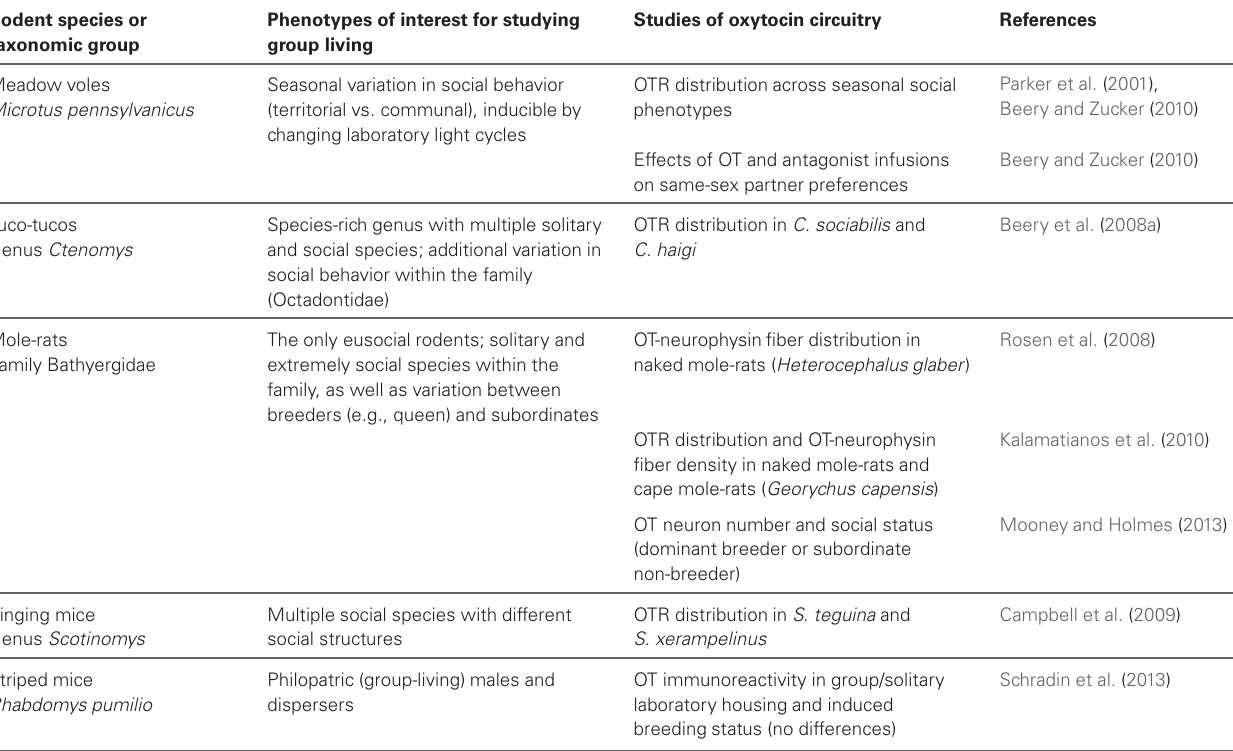
Table 1 | Rodent species for which OT and group-living behaviors have been examined . Rodent species or taxonomic